Question: Sum up the contents of this chart in one sentence.
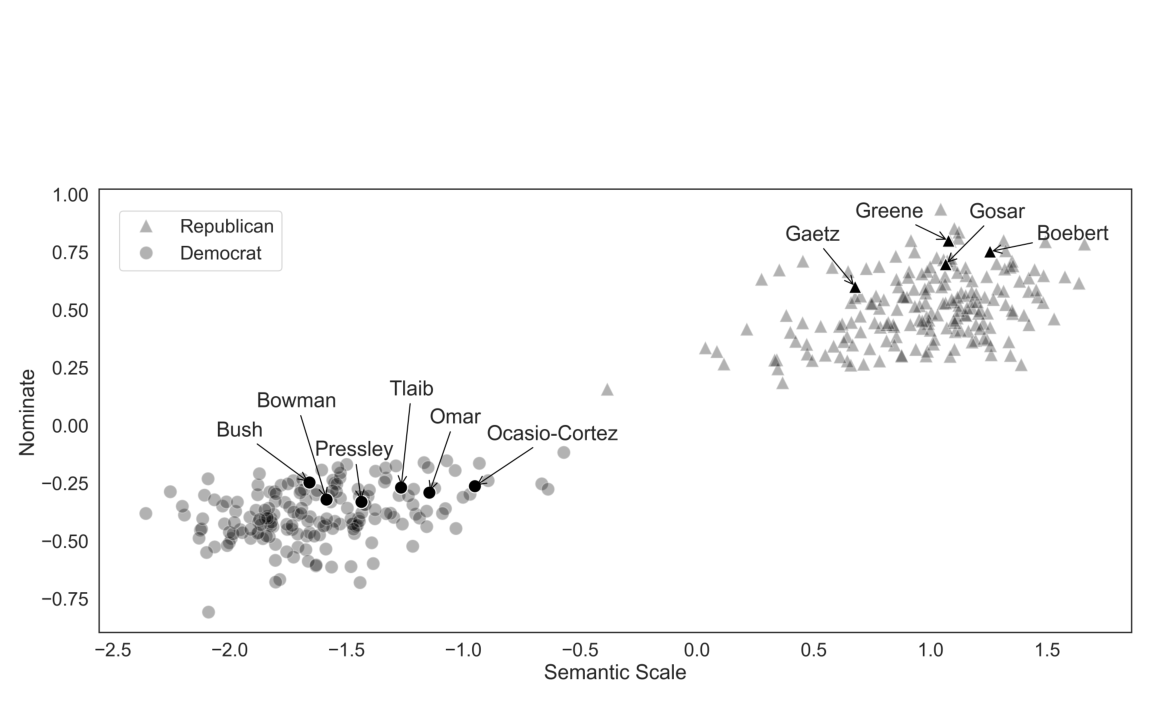
Answer: Both DW-NOMINATE and the Semantic Scale with all items show similar results for House subfactions. The MAGA Squad is clearly conservative while the Squad is perhaps more moderate than would be expected.